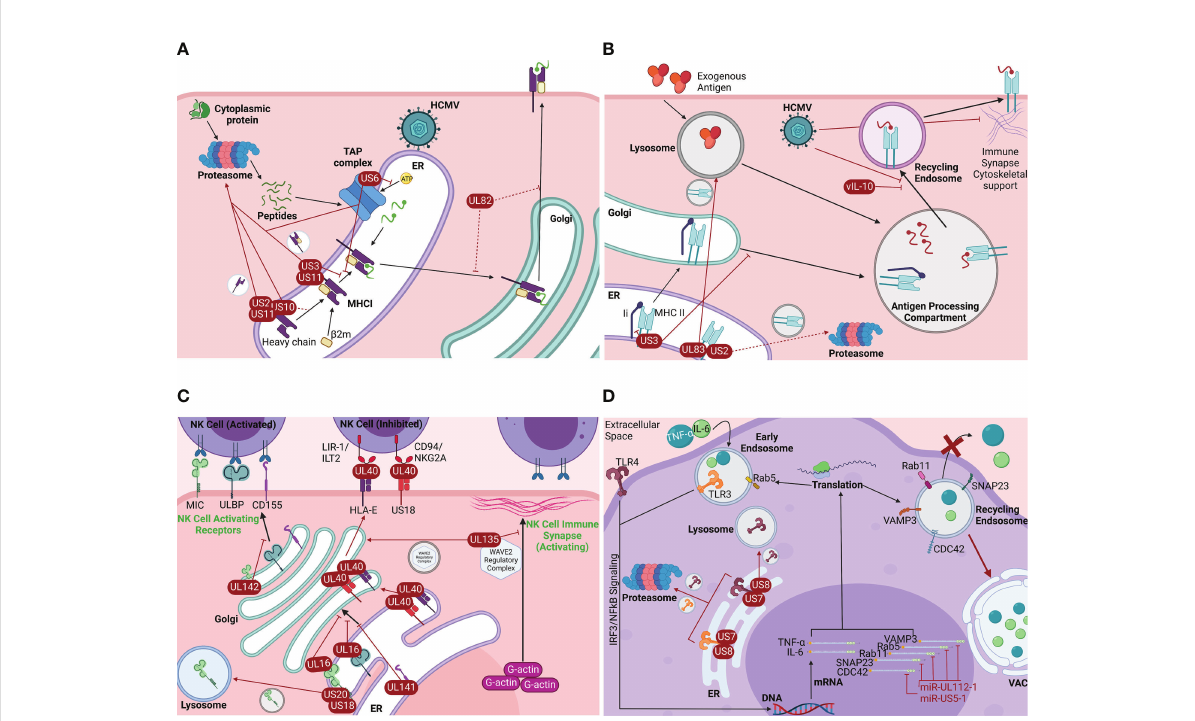
FIGURE 2 HCMV manipulates intracellular traf fi cking components to promote immune evasion. (A) HCMV-induced MHC I traf fi cking disruption. HCMV encodes viral proteins that disrupt the intracellular traf fi cking of the MHC I complex or its components early in the biosynthetic pathway: US2, US3, US6, US10, US11, and UL82 (1, 3, 11, 42 – 45). US2 destabilizes and dislocates free MHC I heavy chains from the ER and promotes their translocation to the cytosol and subsequent proteasomal degradation (1, 42 – 46). US3 binds the immature MHC I complex in the ER and causes its retention in the ER and subsequent proteasomal degradation (3, 42, 44, 45). US6 prevents TAP ATP-binding, which prevents the transport of cytosolic peptides into the ER for loading onto MHC I, in turn causing MHC I retention in the ER and ultimately proteasomal degradation (3, 42, 44, 45). US10 binds the MHC I heavy chain and delays MHC I translocation to the cell surface. US10 can also act similarly to US11 (1, 42, 44, 45). US11 acts in concert with US2, US3, and/or cellular proteins such as UPR-associated Derlin-1 to rapidly dislocate the immature MHC I complex from the ER to the cytosol for degradation. US11 can also interact with individual MHC I heavy chains or immature heterodimers and promote the dislocation of misfolded MHC I complexes (1, 3, 42 – 45). UL82 delays transport of mature MHC I from both the Golgi and ER (45). Viral proteins are shown in red. Dotted lines indicate delayed transport. Made with BioRender.com. (B) HCMV-induced MHC II traf fi cking disruption. HCMV causes the disruption of MHC II traf fi cking. Infection results in the retention of MHC II in an enlarged peptide loading compartment and/ or its degradation (3). Some of the viral effectors involved in MHC I traf fi cking disruption are thought to play a role in MHC II traf fi cking disruption. US2 rapidly dislocates MHC II subunits from the ER, though this event is possibly cell-type speci fi c (red dotted line) (42, 47, 48). US3 inhibits MHC II binding to the variant chain (Ii), which inhibits ef fi cient traf fi cking to the antigen processing compartment and leads to MHC II lysosomal degradation (42, 48, 49). Similar to US2, UL83 binds and dislocates MHC II subunits from the ER to the lysosome for degradation